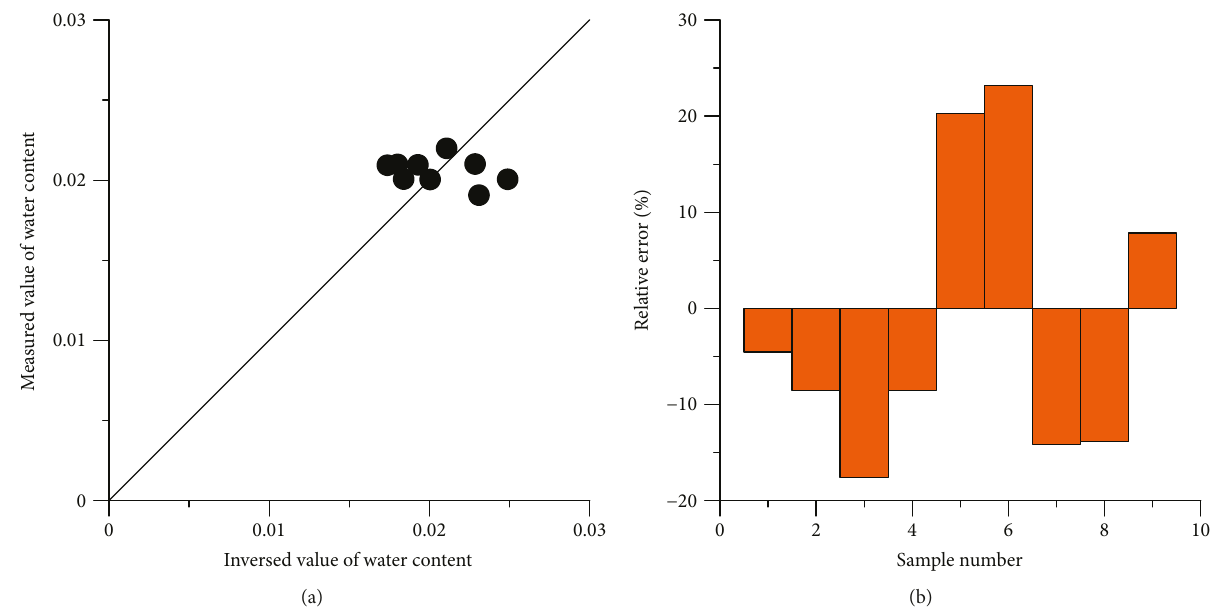
Figure 11: Comparison between the measured and estimated values of water contents. (a) Scatter plot of the measured and estimated values of water contents. (b) Relative errors of water contents. The horizontal axis represents the sample number, while the vertical axis represents the relative error multiplied by a factor of 100.